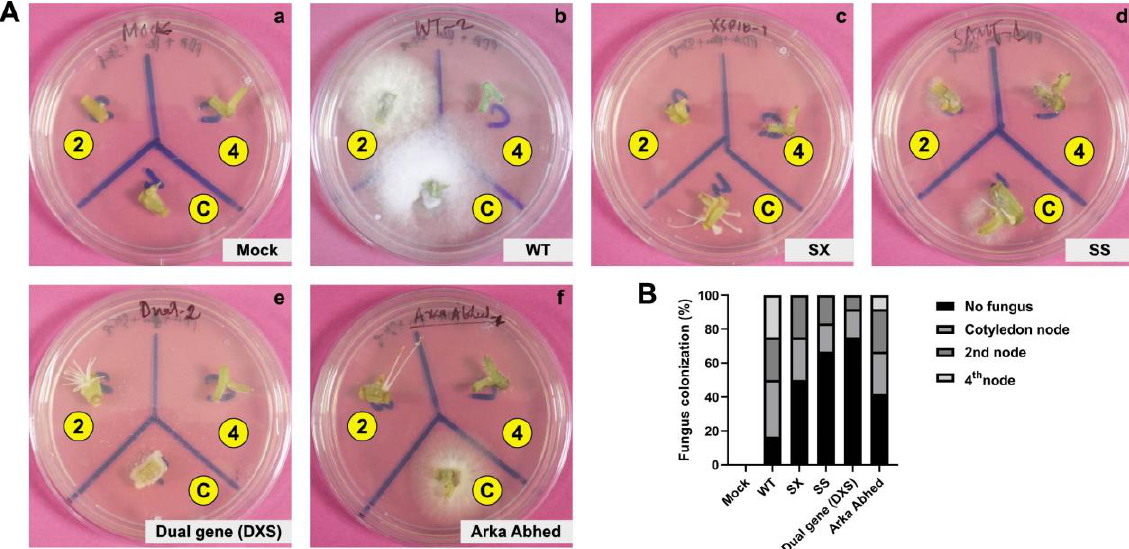
Figure 6. An outgrowth of fungal pathogen Fol 1322 in infected tomato stems . ( A ) Representative picture of stem sections taken from cotyledon node (C) at bottom, 2nd node (2) at top left and 4th node (4) at top right of individual treated plants (n = 4) after incubation for 5 days on potato dextrose (PDA) plates with (penicillin + streptomycin) antibiotics. ( B ) Fungal colonization was expressed as a percentage of stem sliced infected of all stem pieces. All the data were statistically analyzed and no significant differences were observed (Student’s t -test * p < 0.05). L: line.